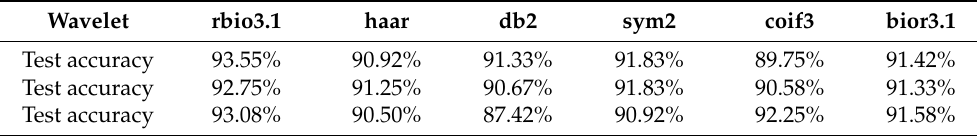
Table 3. Experimental results of signal classification under the use of different wavelets.